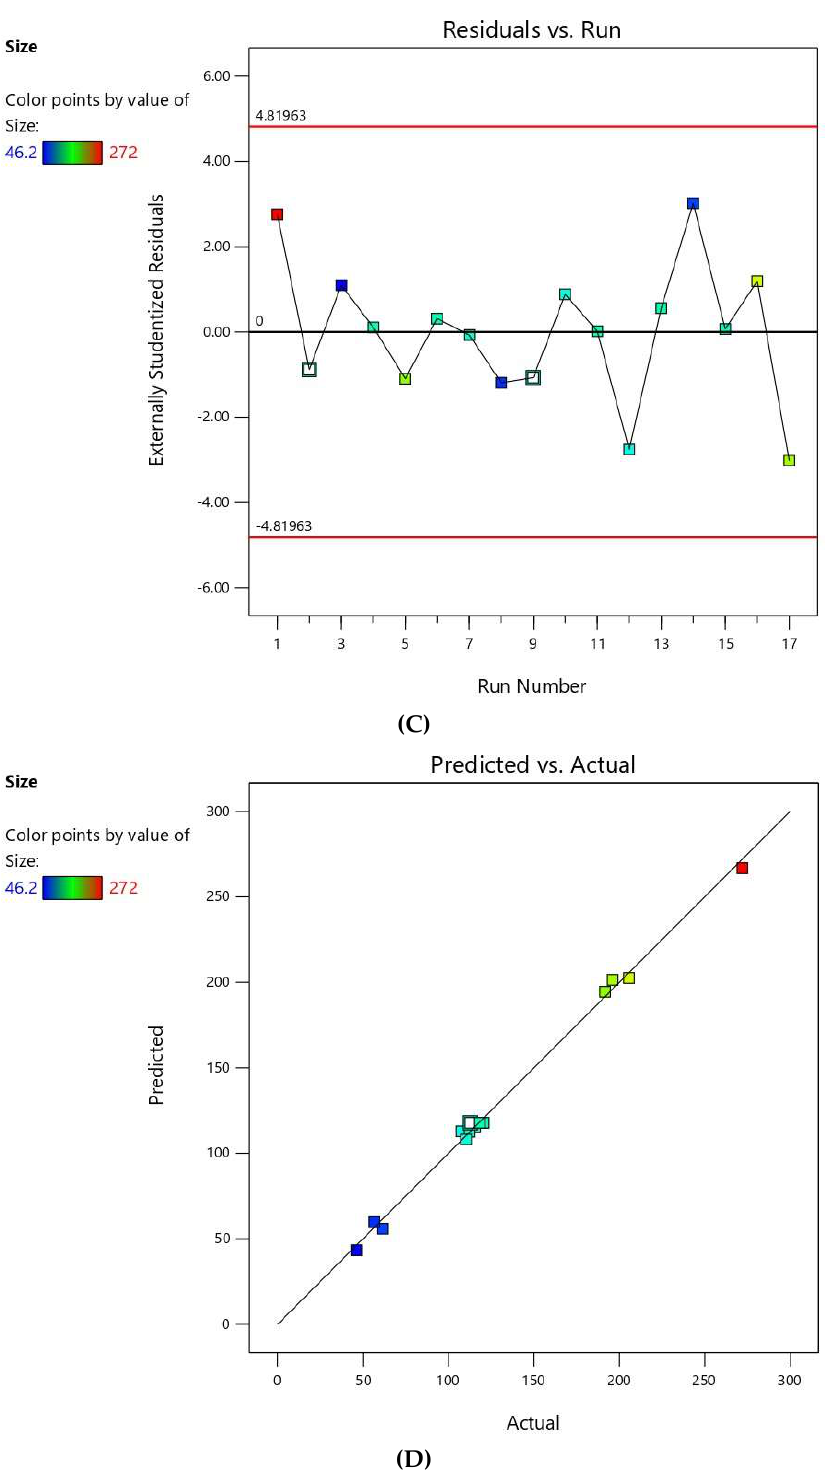
Figure 1. Diagnostic plots for vesicle size of FLB niosomes ( A ); normal probability plot ( B ); studentized residuals vs. predicted values plot; ( C ) externally studentized residuals vs. run number plot; and ( D ) predicted vs. actual values plot.